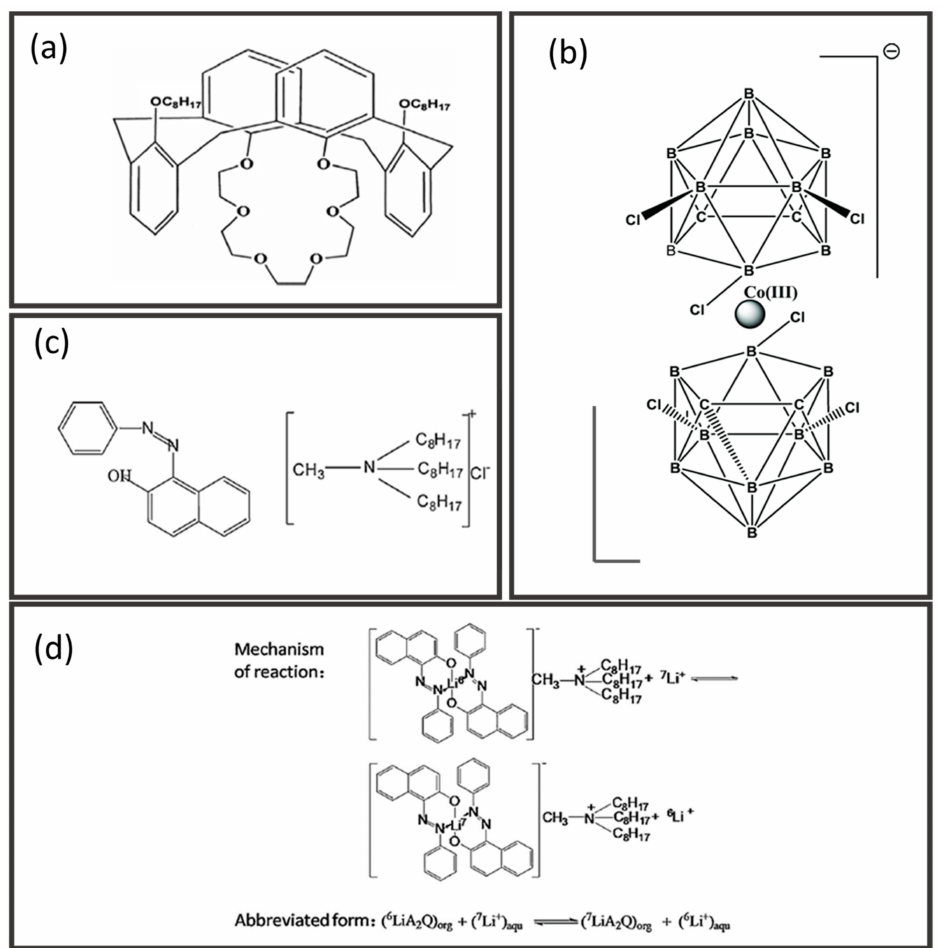
Figure 17. Chemical structure of synergetic ligands: ( a ) bis − octyloxy − calix [4]arene − mono − crown − 6, ( b ) acidic chlorinated cobalt dicarbollide, ( c ) 1 − phenylazo − 2 − naphthol and methyl trioctyl ammonium chloride, and ( d ) lithium isotope and ligands exchange mechanism. Reprinted/ adapted with permission from Refs. [627–629]. Copyright 2014, 2016, and 2020,